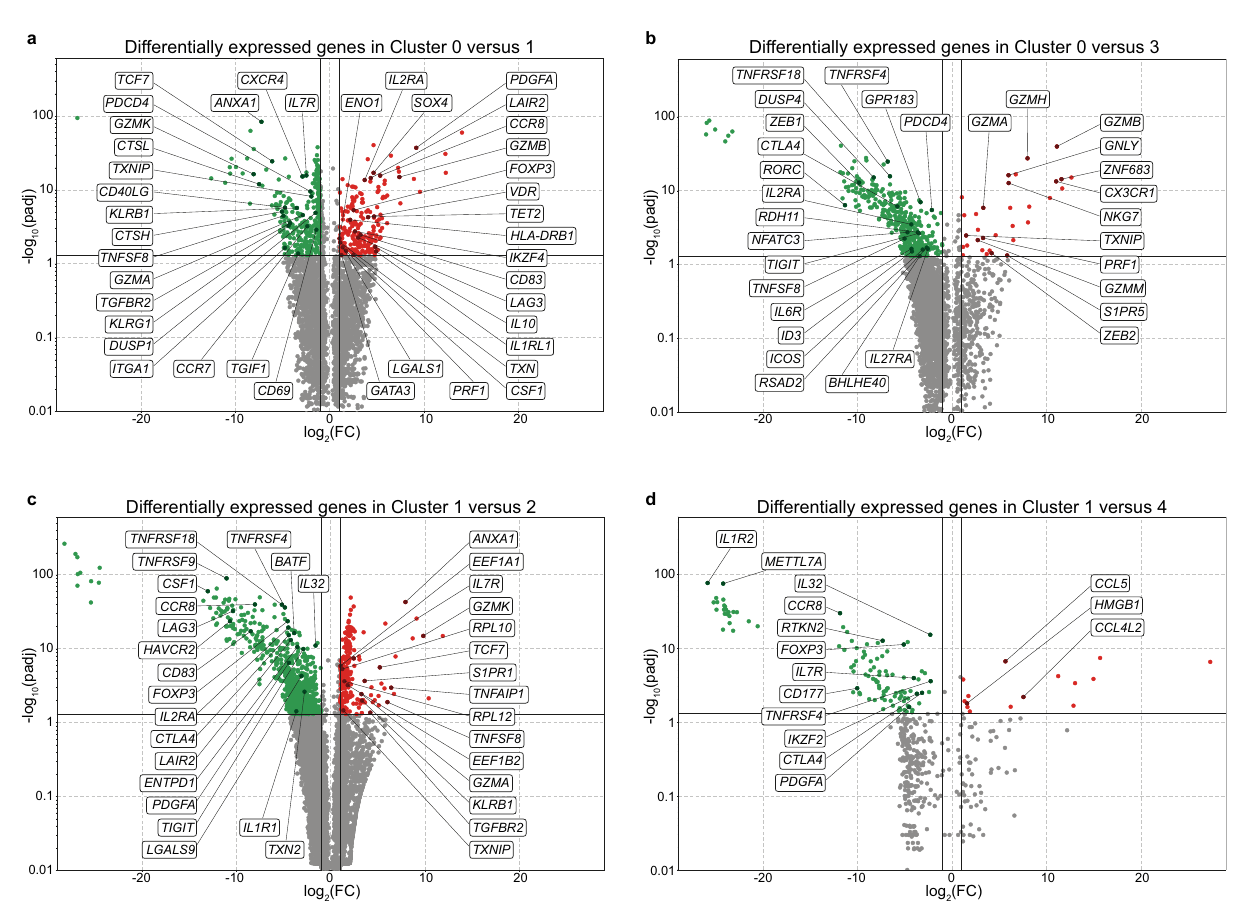
Fig. 4 Differentially expressed genes between transcriptome clusters of tumor-in fi ltrating CD4 + TC. a – d Volcano plots depicting genes differentially expressed between transcriptome clusters of tumor-in fi ltrating CD4 + TC from n = 4 breast cancer patients. n , biologically independent replicates. Pairwise comparison between ( a ) cluster 0 (green) and cluster 1 (red), ( b ) cluster 0 (green) and cluster 3 (red), ( c ) cluster 1 (green) and cluster 2 (red), and ( d ) cluster 1 (green) and cluster 4 (red) using two-class differential expression analysis with the function DESeq with default parameters, which performs negative-binomial generalized linear model fi tting using Wald tests for signi fi cance. FC fold change, padj adjusted P